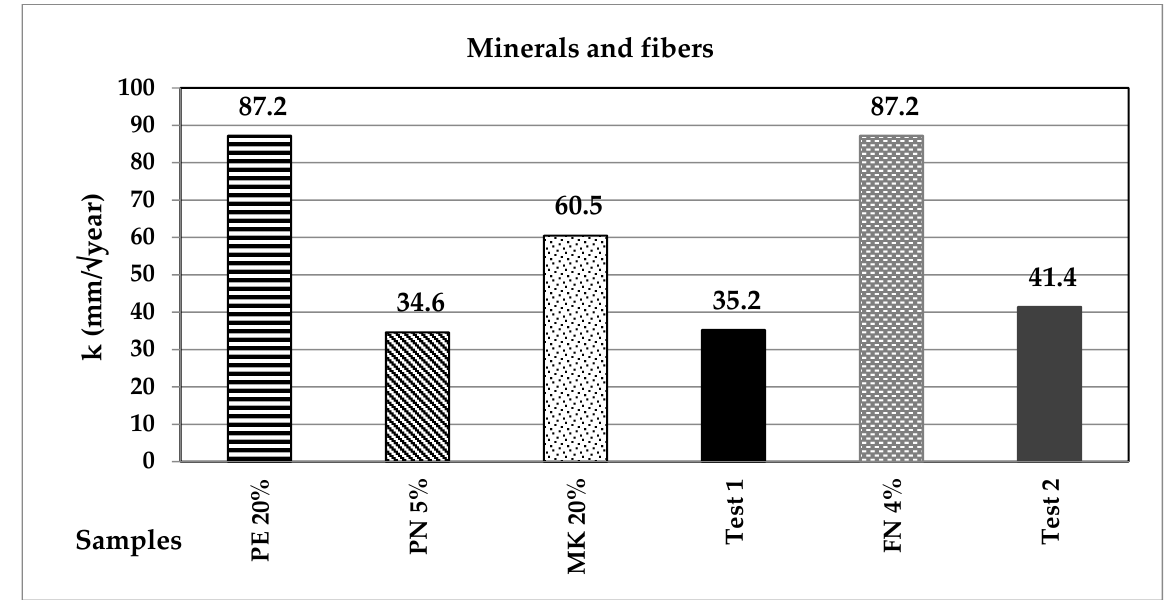
due to the high porosity of the mixtures and the low reactivity of the pozzolanic compounds with the alkalis existing after the hydration of the PC. Figure 13. Constant k for the agricultural and industrial wastes group of additions.